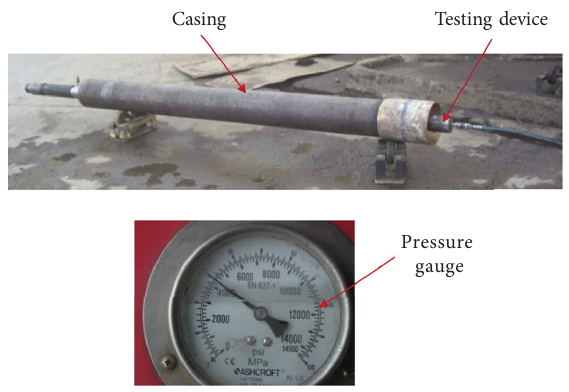
Figure 24: Pressure testing device and pressure gauge.